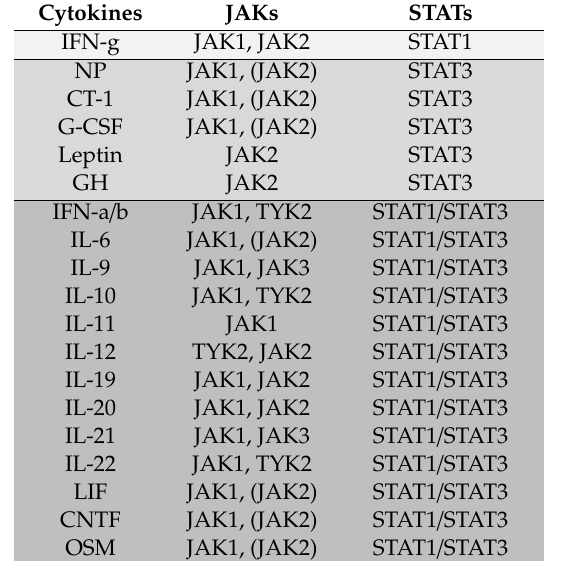
Table 1. Cytokines, growth factors and related JAKs involved in the activation of STAT1 and STAT3